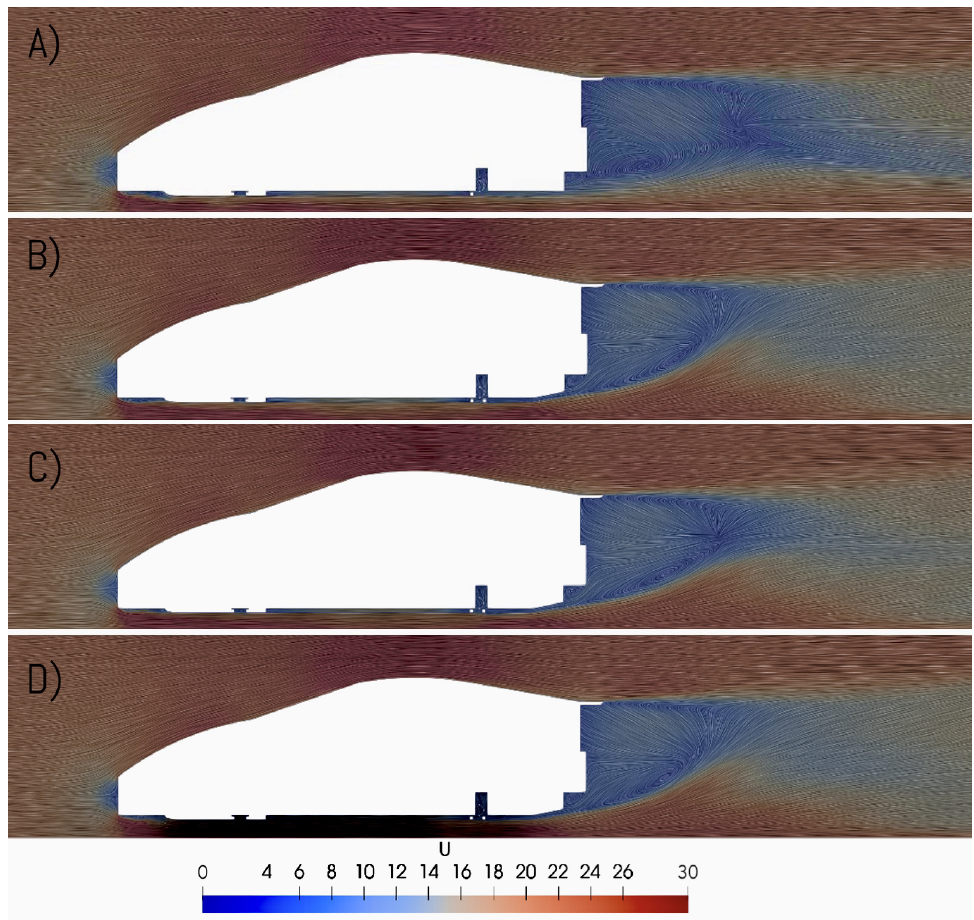
Figure 16. Velocity distribution on the YZ-plane of ( A ) baseline, ( B ) Venturi diffuser, ( C ) Venturi skirt, and ( D ) Venturi frontal configurations. Units are m/s.